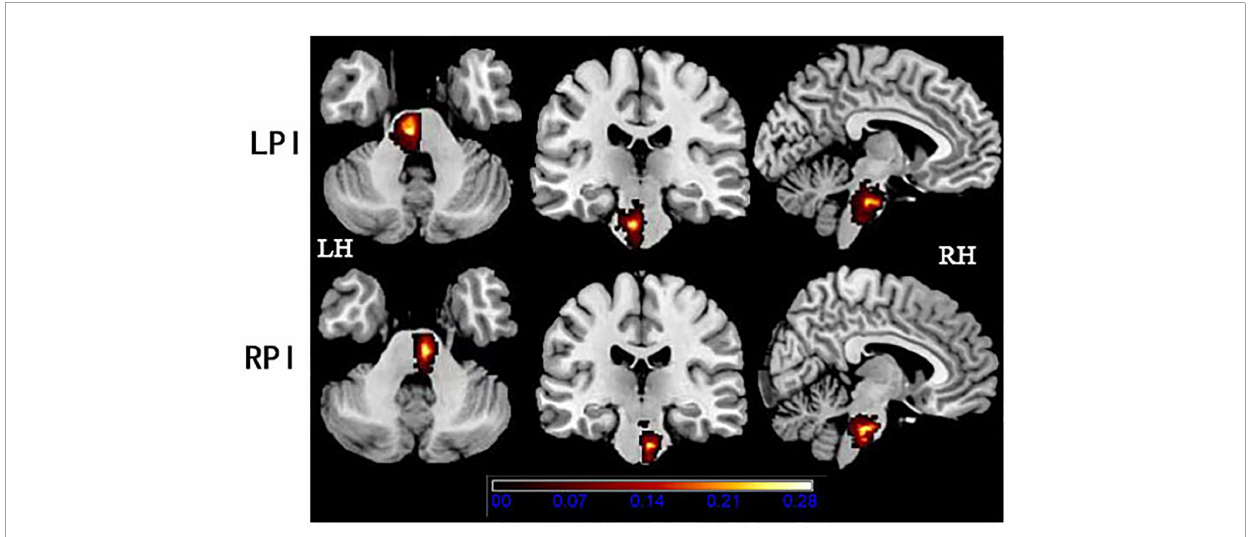
FIGURE1 Lesion distribution in the LPI and RPI groups. The color bar represents the lesion probability. LH, left hemisphere; LPI, left pontine infarction; RH, right hemisphere; RPI, right pontine infarction.